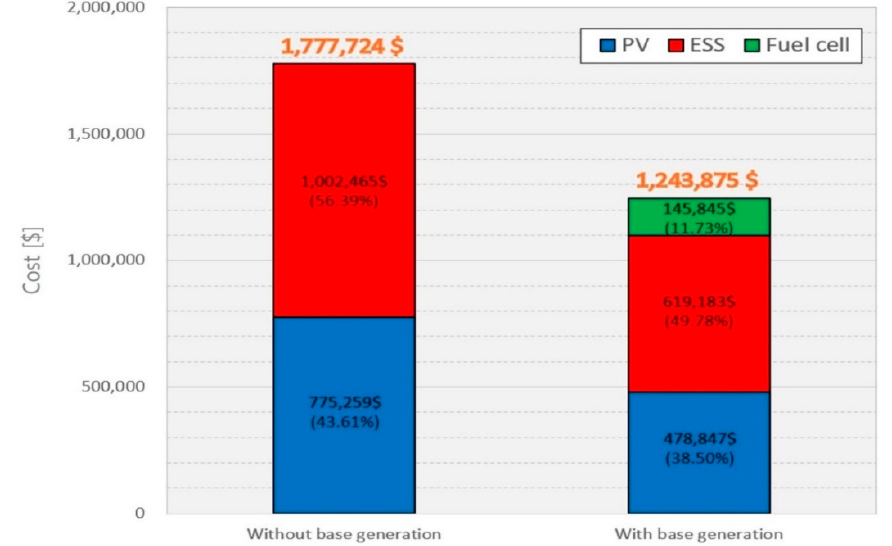
Figure 6. Cost comparison according to the presence or absence of a base power source.